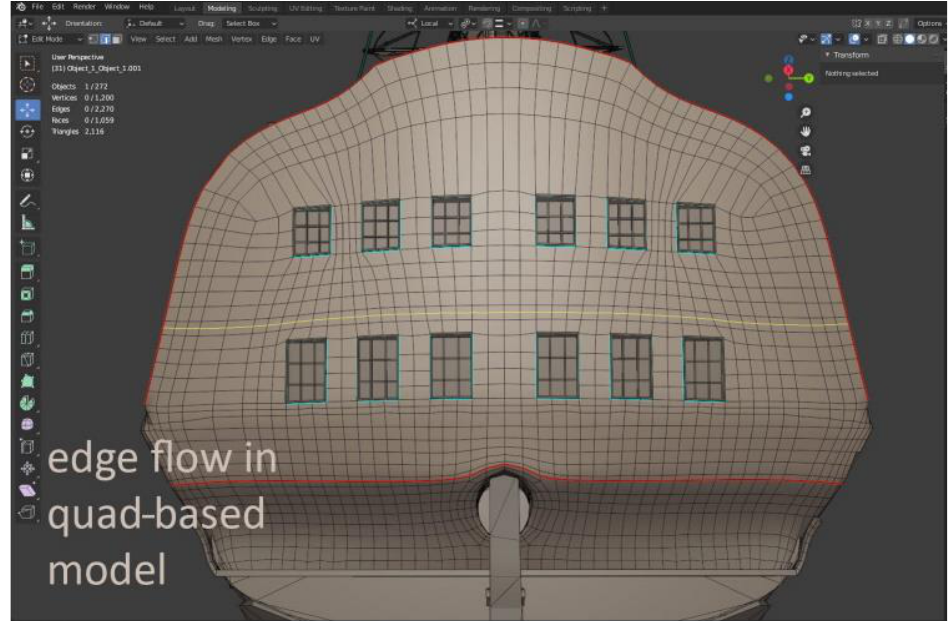
Figure 8 . The same model after retopology with edge flow. Screenshot from Blender.